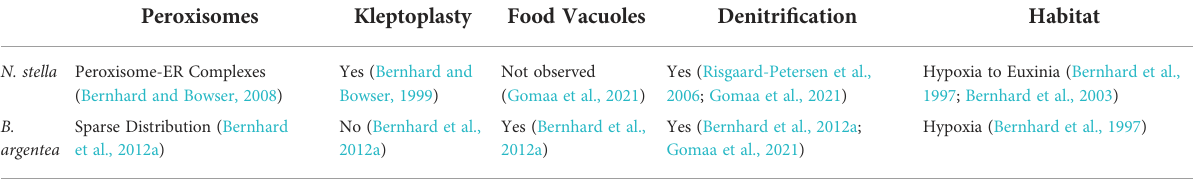
TABLE 1 Distinctive cytology and ecophysiology of N. stella and B. argentea